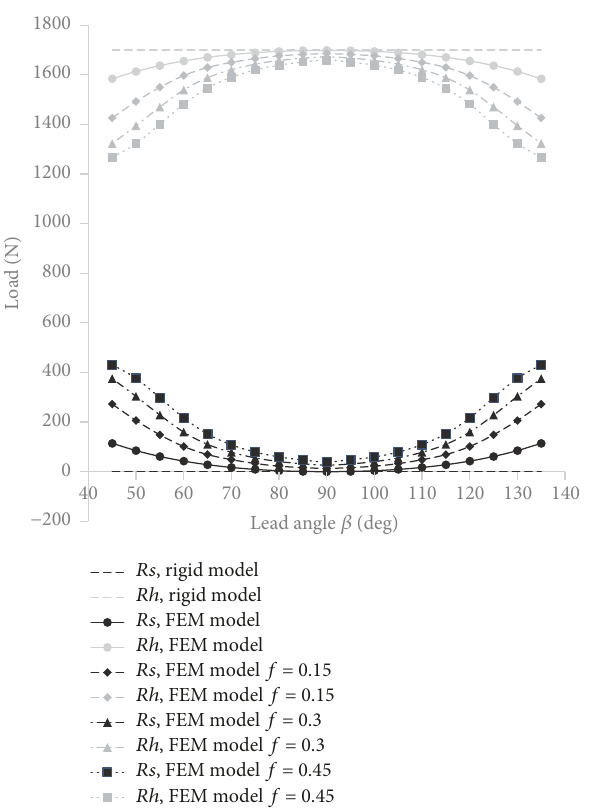
Figure 8: Reactions of shaft and hub constraints for different lead angles under torque load calculated by means of frictionless rigid and FEM model without and with